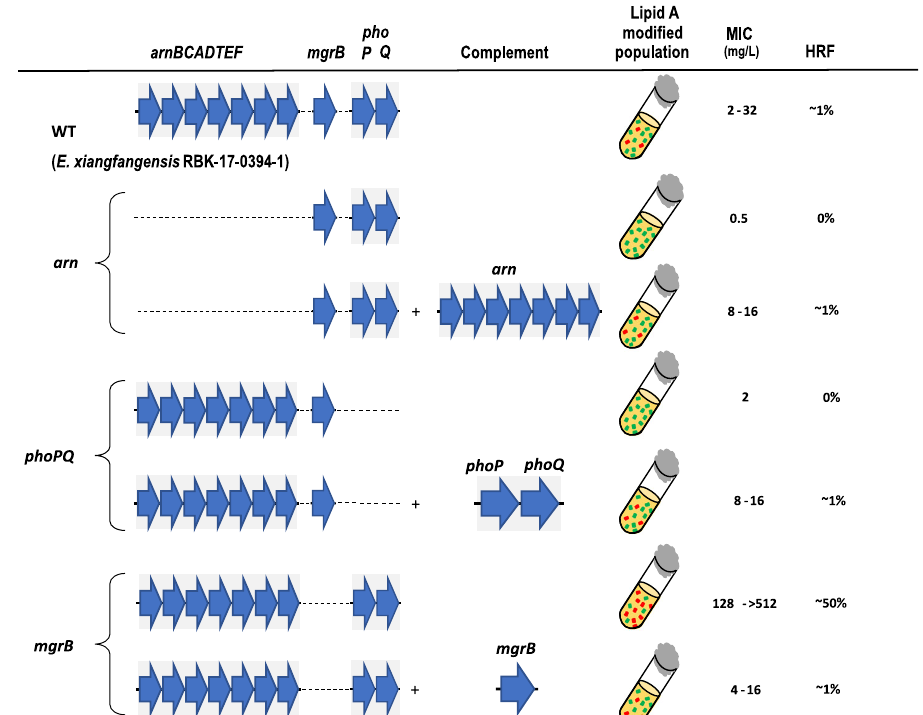
ofcolistin/numberofcellsinoculated).MIC LB wasmeasuredbyBMDwhileHRFwas calculated by PAP test. Analysis of mutants showed the phoPQ/arnBCADTEF axis is absolutely required for the colistin heteroresistance, whileMgrB acts asa negative regulatorof arnBCADTEF resulting incolistinsusceptibility.Asreportedpreviously by Kang et al. 22 for E. cloacae , PmrAB did not contribute to colistin resistance in E. xiangfangensis . Source data are provided as a Source data fi le. The MIC data is provided in the Source data fi